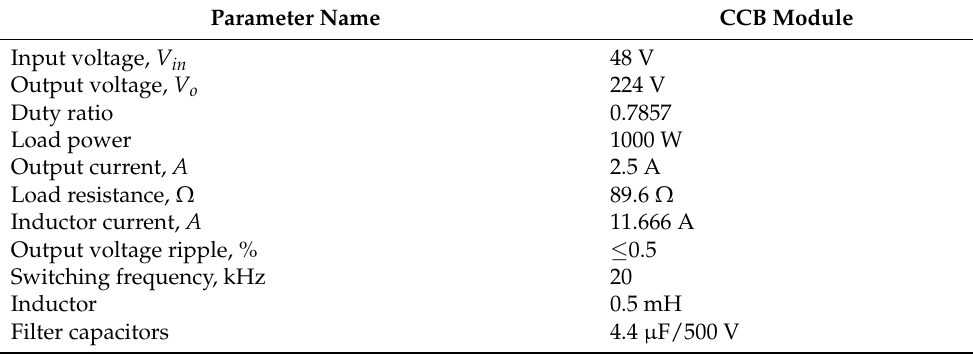
Table 1. Parameters of the proposed